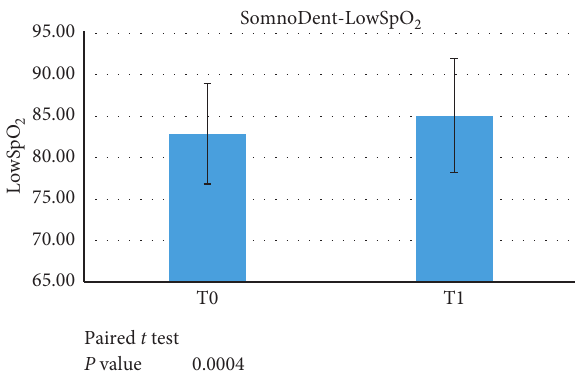
Figure 7: Paired t -test data showed a significant difference between LowSpO 2 at T0 versus T1 ( p < 0 . 05) when evaluating the use of the SomnoDent device.